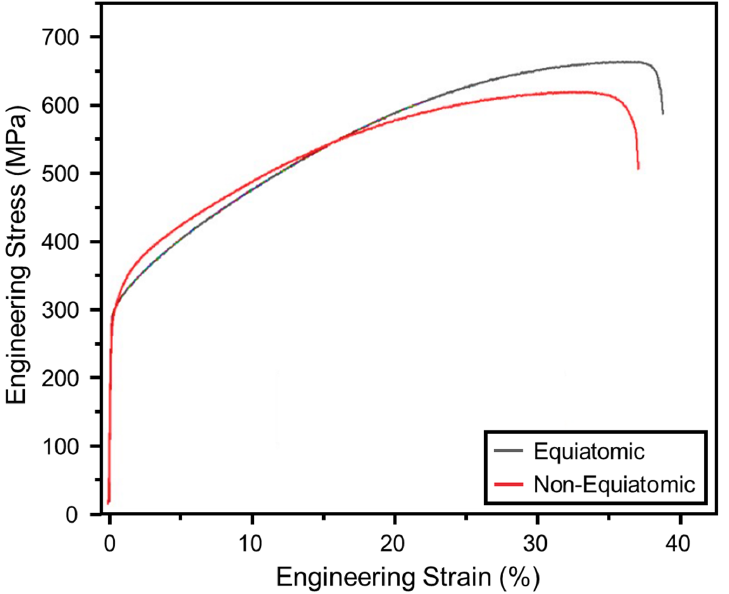
Figure 15. Tensile stress – strain curves for both the equiatomic and non-equiatomic alloys.